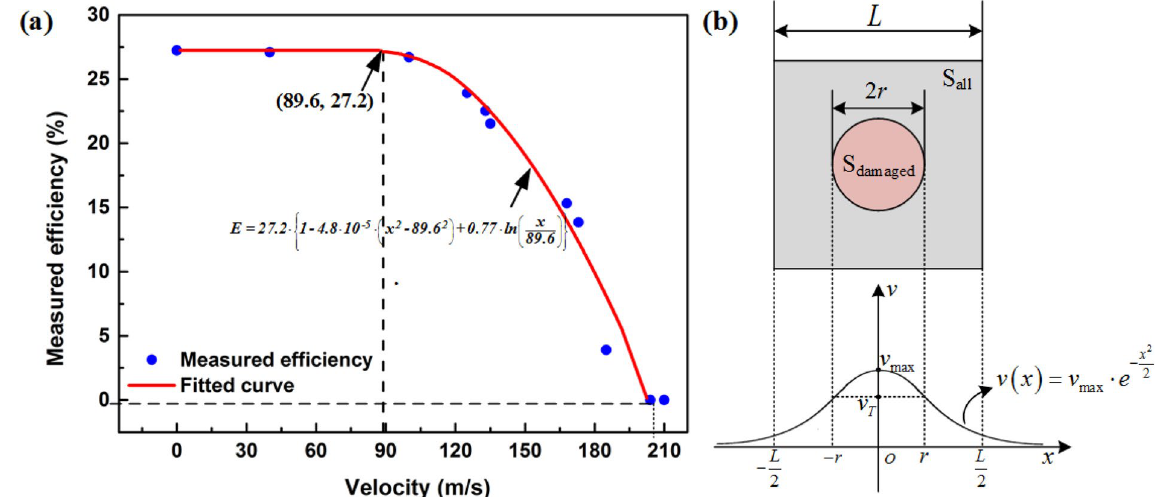
Figure 4. ( a ) Efficiency reduction versus impact velocity of massive particles. ( b ) Schematic of the evaluation model for predicting impact-induced damage of the PV cells by massive